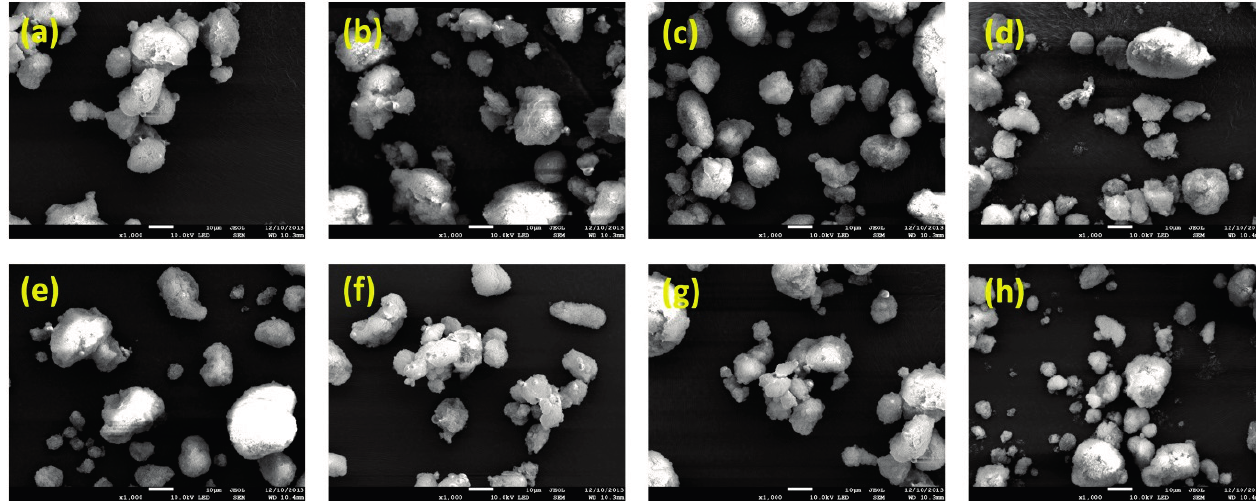
Figure 3. Scanning electron micrographs of dutasteride-loaded solid-supersaturatable self-microemulsifying drug delivery systems (SMEDDS): ( a ) SMEDDS:Aerosil 200; ( b